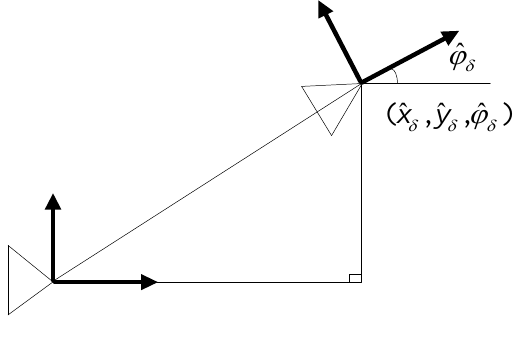
Figure 11. The robot motion model.